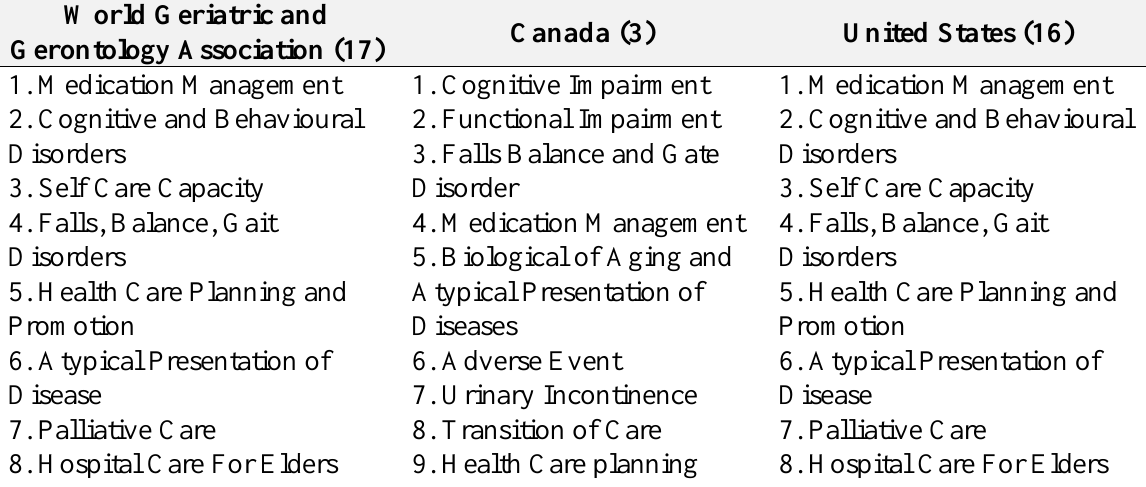
Table 3. Minimum geriatric competencies for medical